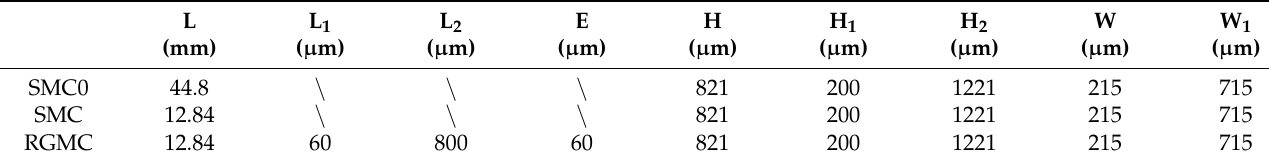
Table 1. Dimensions of the SMC and RGMC microchannels.